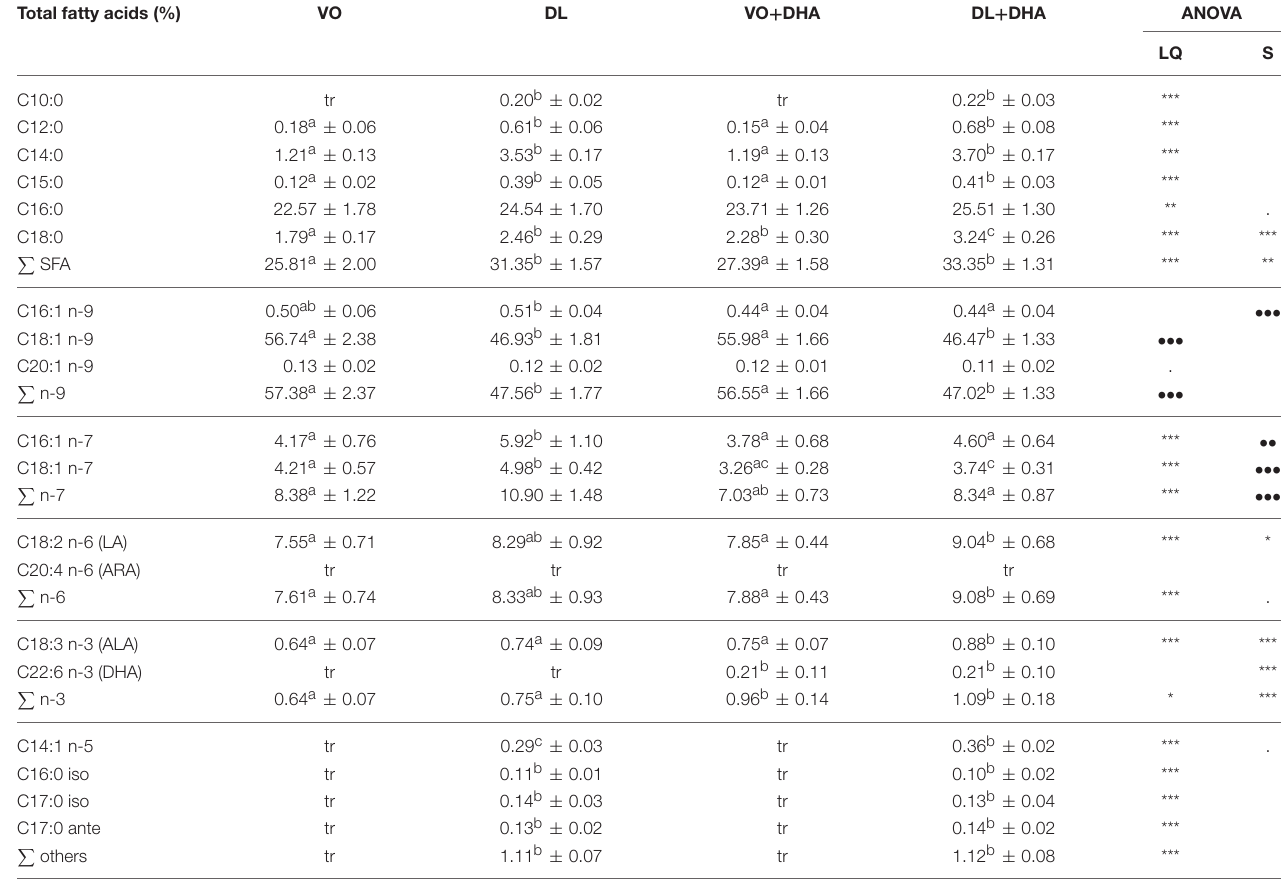
TABLE 3 | Total fatty acids composition of epididymal adipose tissue of rats fed the four diets. Total fatty acids (%)